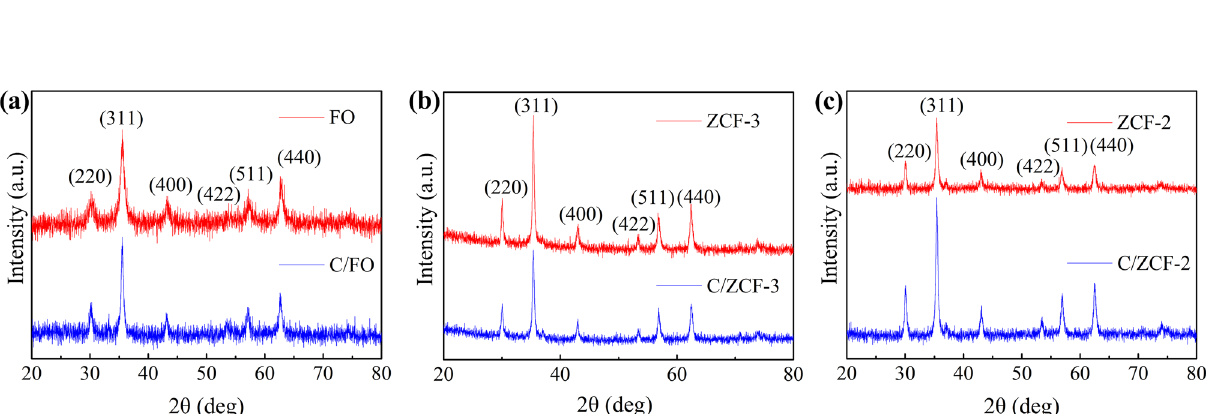
Figure 2. X-ray diffraction patterns of MNPs: ( a ) FO and C/FO, ( b ) ZCF-3 and C/ZCF-3, ( c ) ZCF-2 and C/